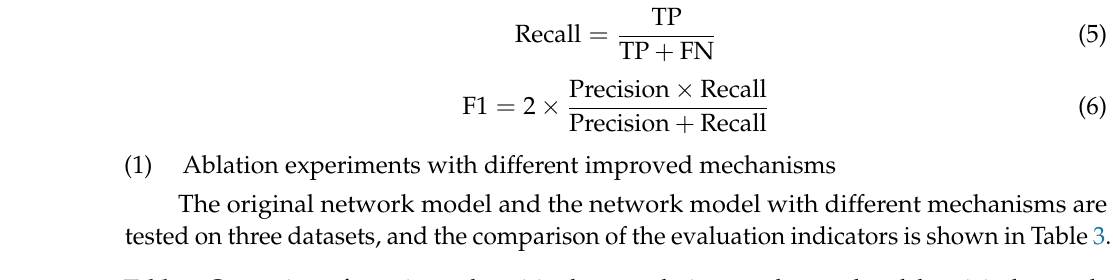
Table 3. Comparison of experimental precision between the improved network and the original network.